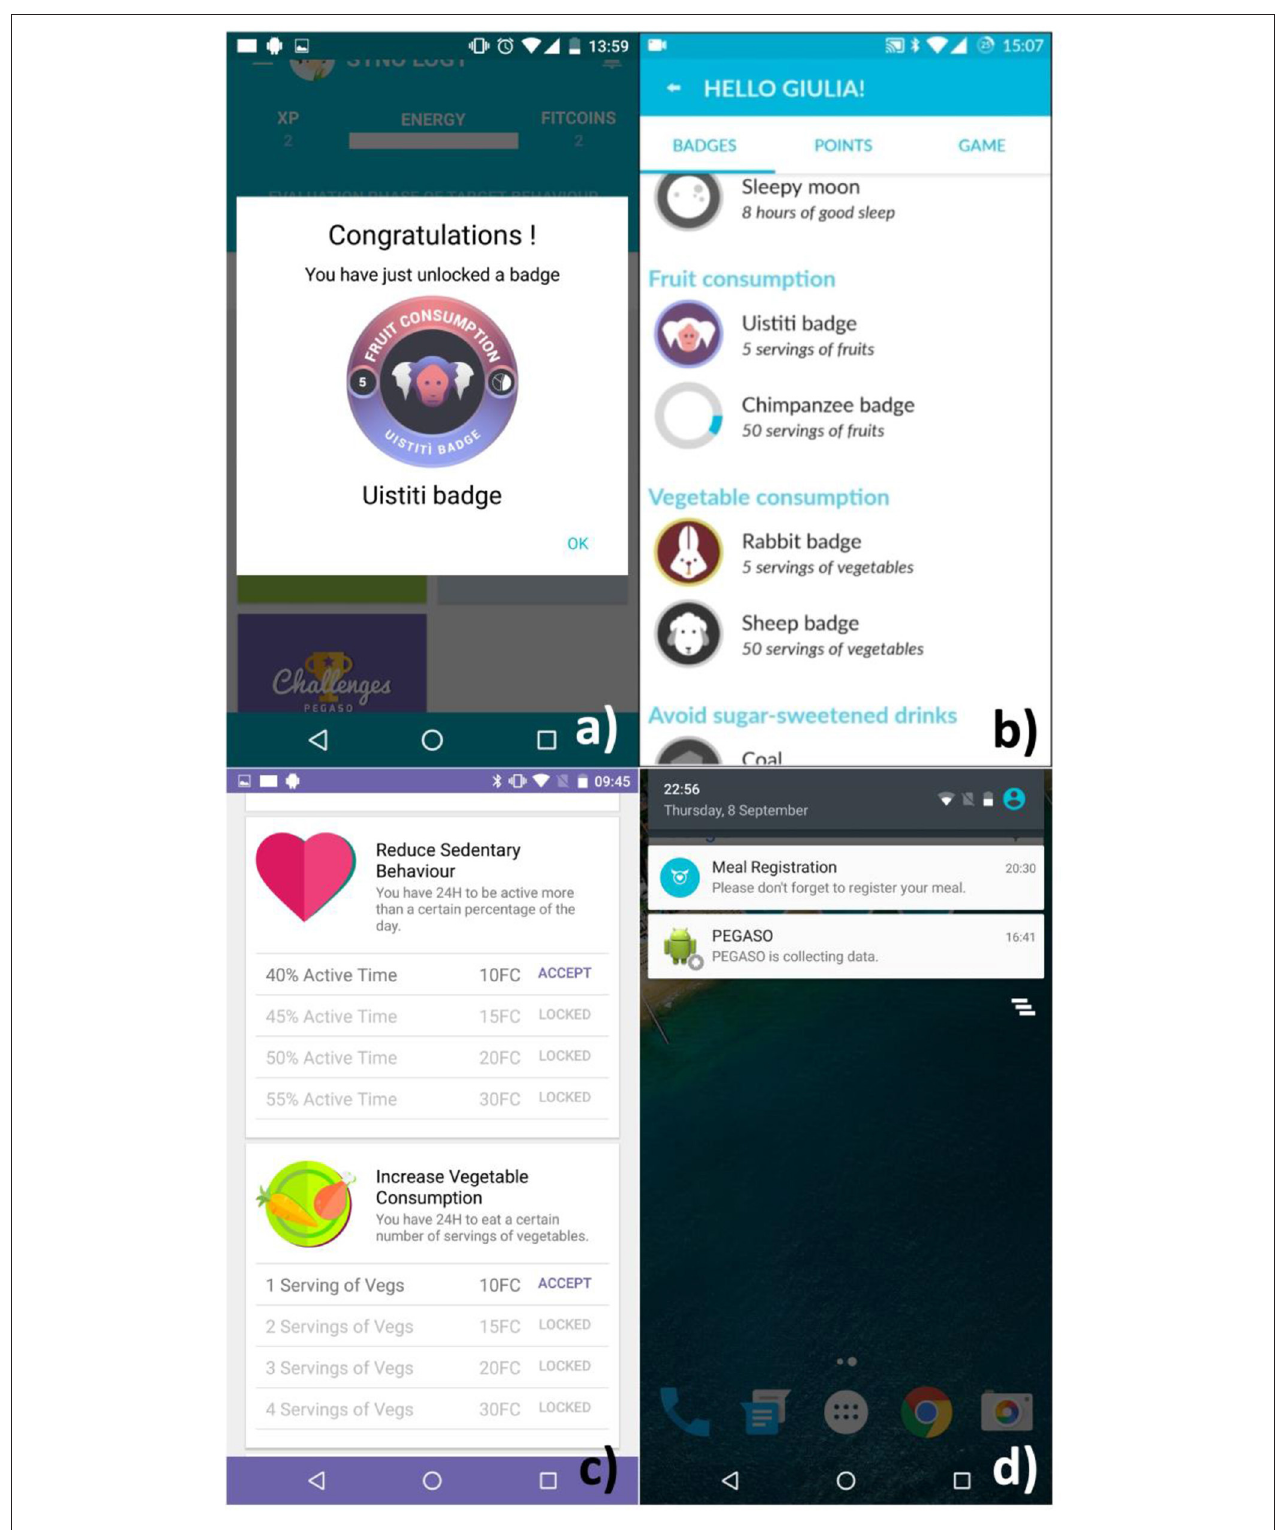
FIGURE 6 | The Companion app provided: badges related to the activity on the e-Diary as depicted in (a,b) ; challenges based on DTBs as shown in (c) ; notifications to encourage the use of the app as in (d) .